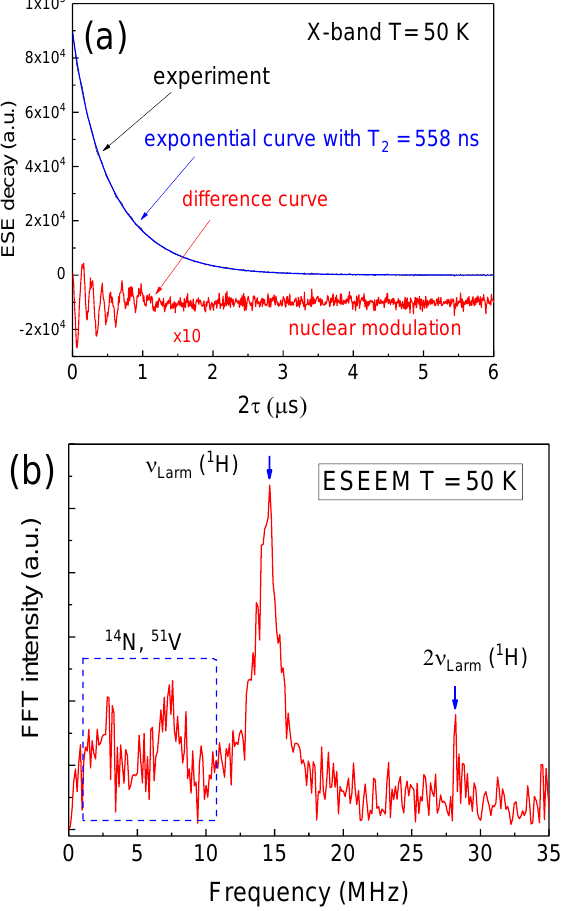
Figure 6. ( a ) FR ESE decay in the X-band for A2 registered at T = 50 K (black); T 2 -curve (blue) and their scaled difference (red); ( b ) fast Fourier transformation from the red curve in Figure 6a. Values corresponding to the Larmor frequencies for 1 H, 14 N, and 15 V are marked (cf Table 2). Table 2. Frequencies of the experimental obtained (exp.) signals (Figure 5b) and calculated (calc.) values of the Larmor frequencies for certain nuclei in the X-band for B = 345.3 mT. 1 H, ν Larm (MHz) 14 N, ν Larm (MHz) 51 V, ν Larm (MHz) 13 C , ν Larm (MHz) Exp. Calc. Exp. Calc. Exp. Calc. Calc.